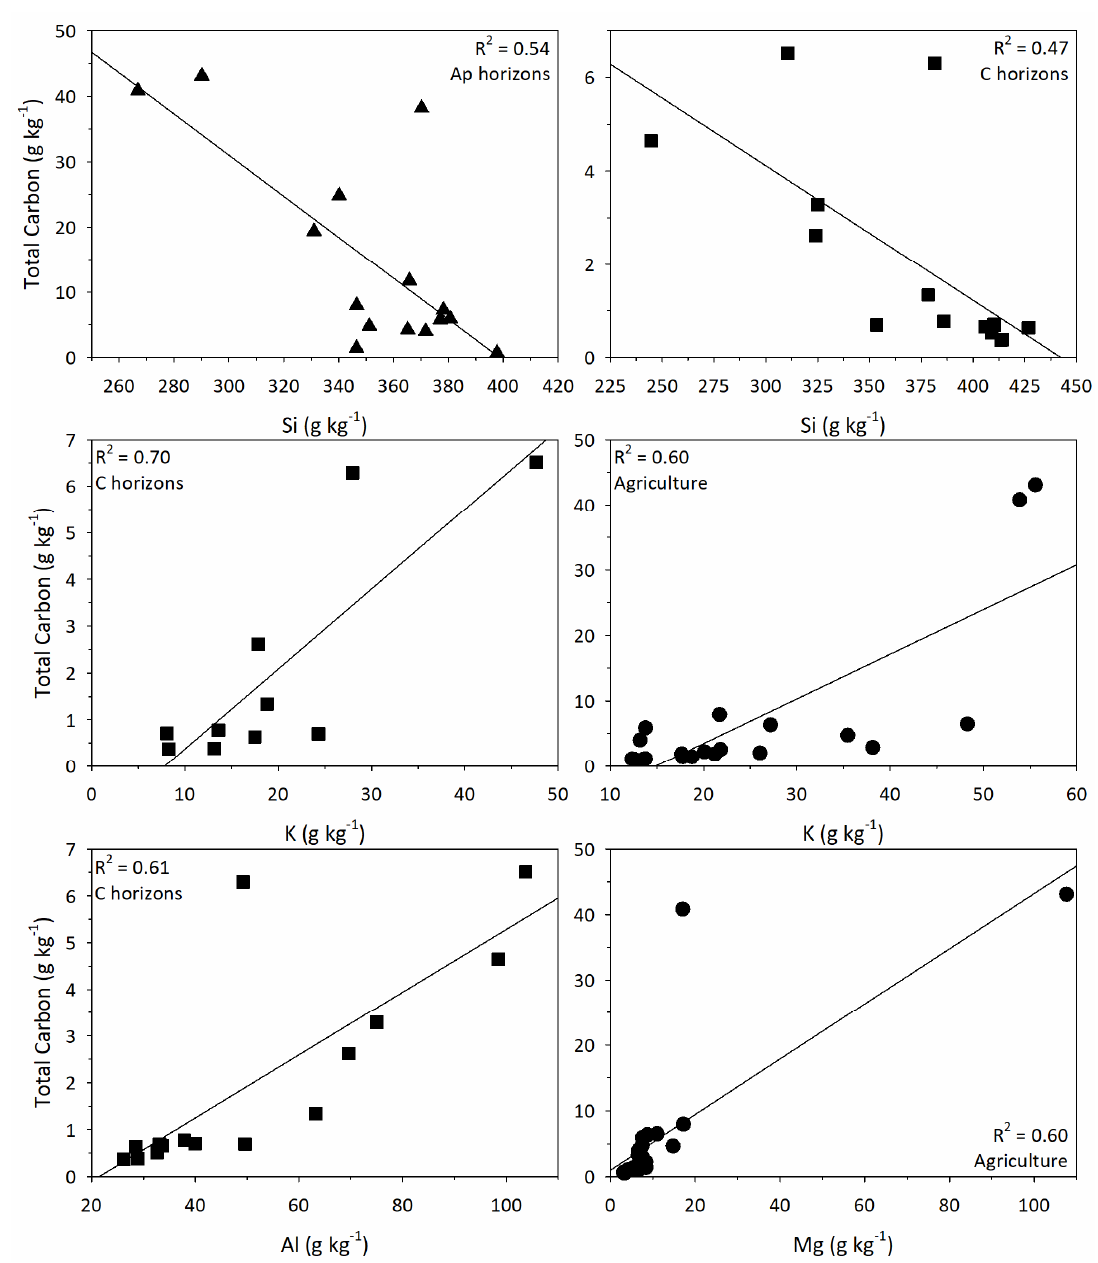
Figure 5. Relationships between soil carbon and Si, K, Al, and Mg in the different particle sizes by horizon and land use using EDS data. Line represents linear fit.